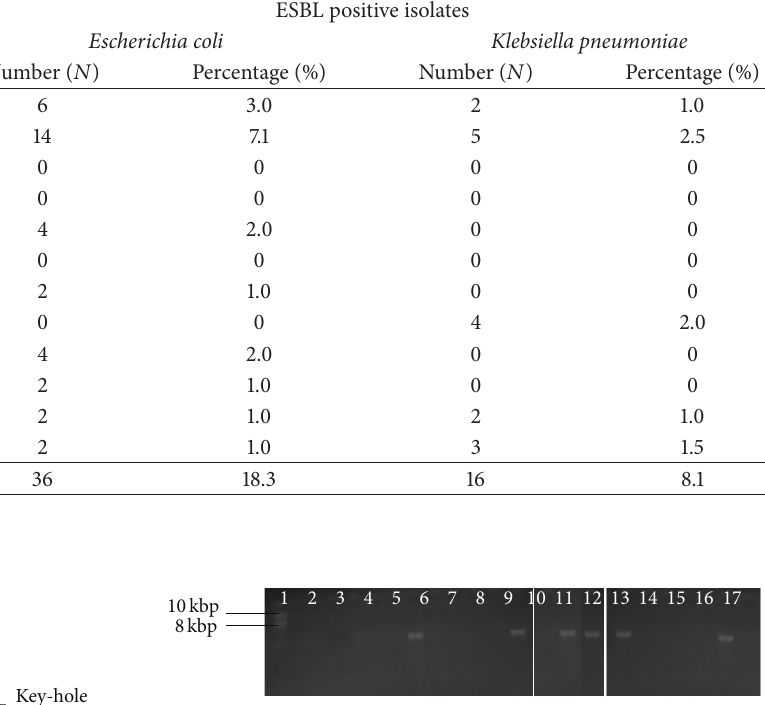
Figure 2: Agarose gel electrophoresis of plasmid DNA after curing.